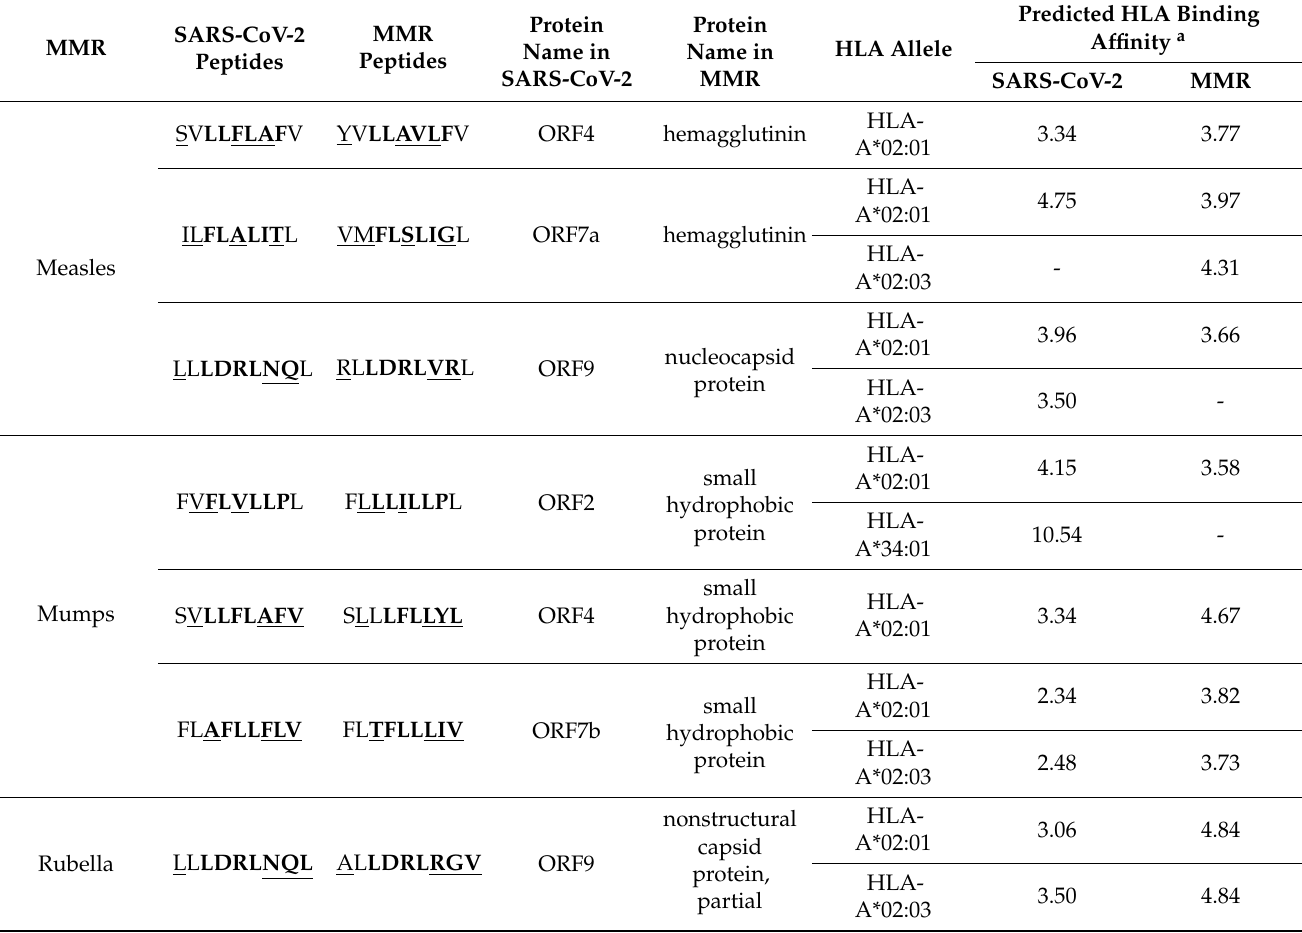
Table 12. Cross-reactive CTL epitopes between SARS-CoV2 and MMR vaccine. The amino acid substitution is indicated by underlining and TCR contact residue is indicated by bold